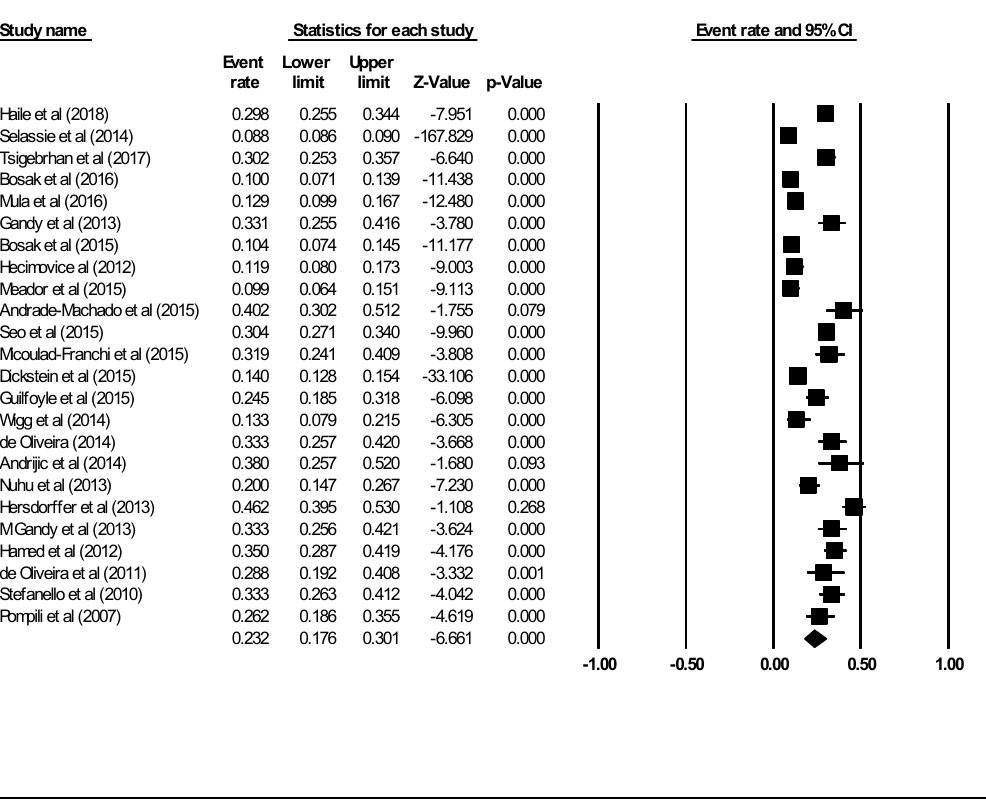
Figure 5. Forest plot of pooled rate of rate of suicide ideation among PWE.